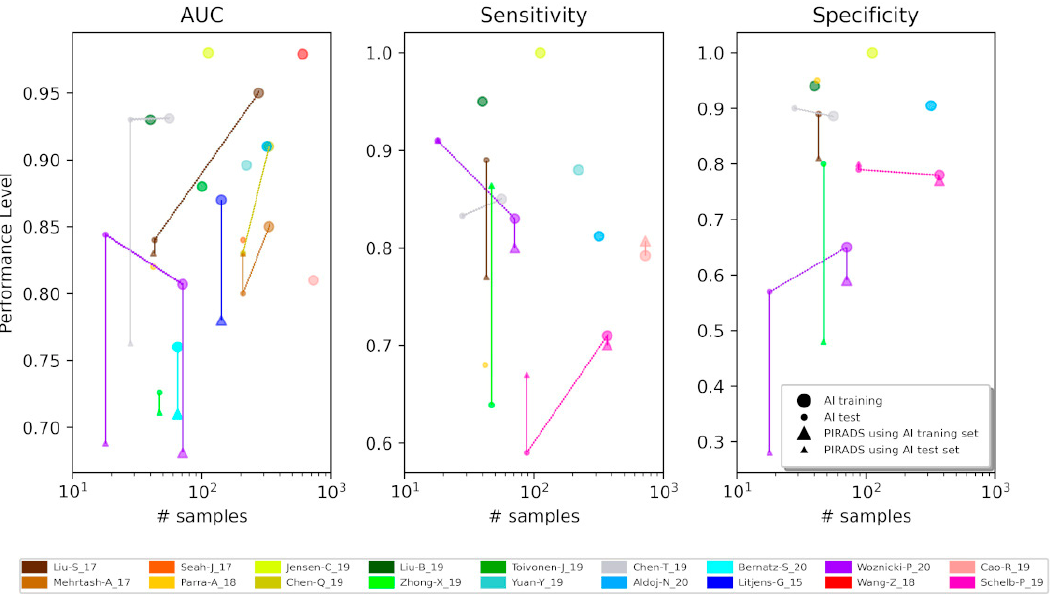
Figure 1. Scatter plots showing the trends of the classification performance (AUC, Sensitivity, and Specificity) against the number of samples. When different models were implemented, the best results have been picked. The bigger symbols represent the performance achieved by training sets, while the smaller ones are by test sets. The round-shaped dots indicate the performance level obtained through AI models while the triangle-shaped dots by PI-RADS score. The two are linked by a bold line. Conversely, dotted lines connect performance evaluated with training and test sets obtained from the same AI model. Each color represents a specific study, as reported in the legend below the plots. In case this paper is read in html format, when a point is mouse hovered, a tip will pop up with the name of the paper, the dataset (training or test set), the number of samples, the performance (AUC, sensitivity or specificity value), the classification task, and the method description (AI model or PI ‐ RADS) [see Table S1 if the html is not available].